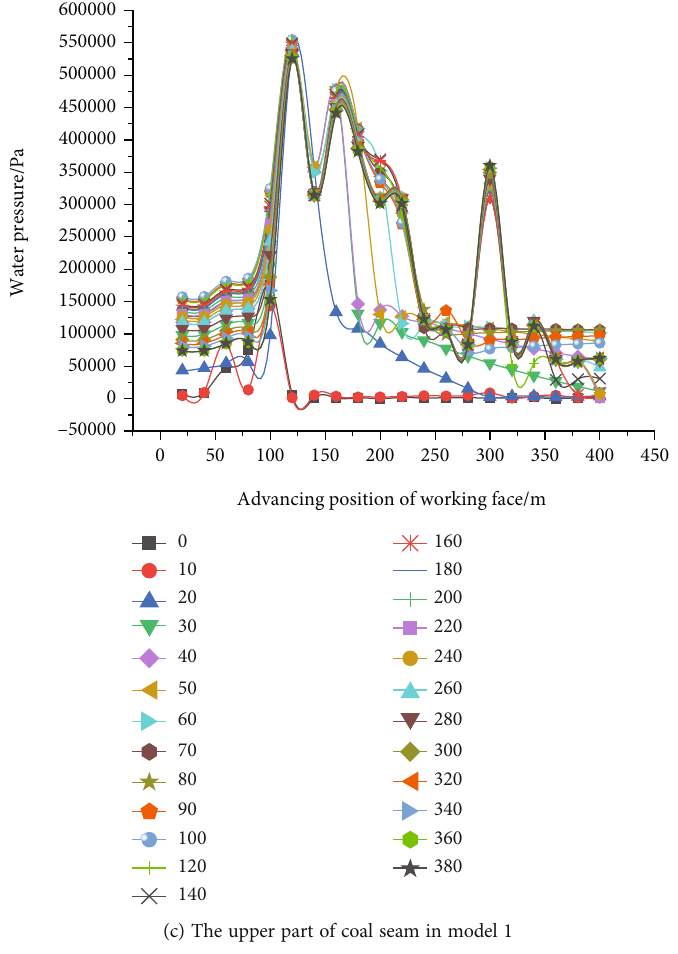
Figure 9: Variation law of water pressure at coal